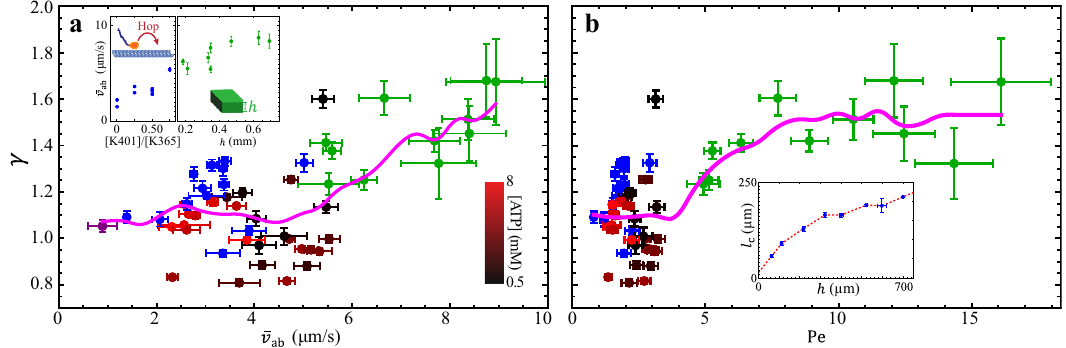
Fig. 4 | (Experimental results) Transition of active-inactive interface progres- each error barin (cid:1) v ab represents the standard deviation of fl owspeeds in the active sion. Progressionof the active-inactive interface transitions from diffusion-like ( γ ≈ region. Inset: The fl ow-speed level of the active fl uid is tuned by replacing pro- 1) to superdiffusion-like ( γ > 1) as the active transport changes from diffusion- cessive motors (K401) with nonprocessive motors (K365) with the same overall dominated(Pe ≲ 3)toconvection-dominated(Pe ≳ 3). a Theactive-inactiveinterface motorconcentrations(120nM)(left) 36,48 orbyalteringthesampleheight(right) 48,52 . b ThesamedataasinPanela,plottedasafunctionofPécletnumber,Pe (cid:2) (cid:1) v ab l c = D , progression exponent ( γ ) increases with the fl ow-speed level of the active fl uid where l c is the correlation length of fl ow velocity in active fl uid deduced from ( (cid:1) v ab ).ShownaredatafromexperimentswithlowATPconcentration(0.5mM,black dots), high ATP concentration (8mM, red dots), decreased fl ow speeds (from sample container height h (inset) and D is the diffusion coef fi cient of ATP. Each nonprocessive motors partially replacing processive motors; blue dots), increased error bar in γ is the same as in Panel a, and each error bar in Pe represents pro- fl ow speeds(from increasedsampleheight; green dots) 48 , and both nonprocessive pagateduncertaintiesfrom (cid:1) v ab inPanelaand l c ininset.Inset:Correlationlengthof fl owvelocityinactive fl uid l motors and increased sample height (purple dot). The magenta curve represents c increasesmonotonicallywithsamplecontainerheight the moving average of γ . Although the analyzed γ from each experiment is noisy, h 39 . The red dashed line represents the line interpolation of blue dots. The error the moving averaged γ exhibits anoverall monotonic increase with the fl ow-speed barsrepresentthestandarddeviationsoftwotrials.(SeeSupplementaryNote4for level of active fl uid (cid:1) v ab . Each dot represents one experimental measurement. Each measurements and analyses of l c (cid:9) (cid:10) + γ ln t (Fig.2a),and errorbarin γ representstheslope fi ttingerrorinln Δ x 2 =ln 2 P I